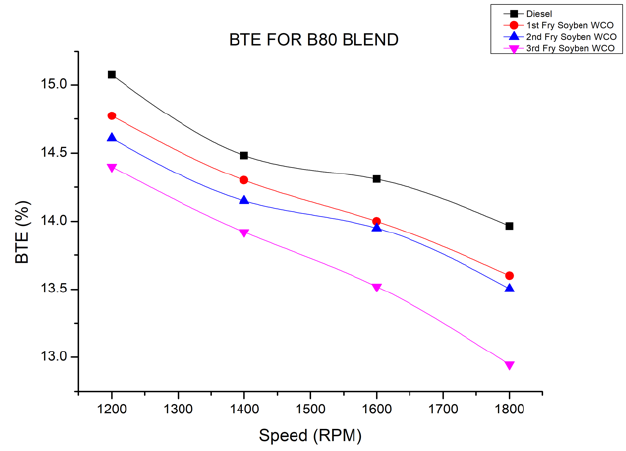
Figure 5. BTE of different fry oils (B80 blend) at different rpm.